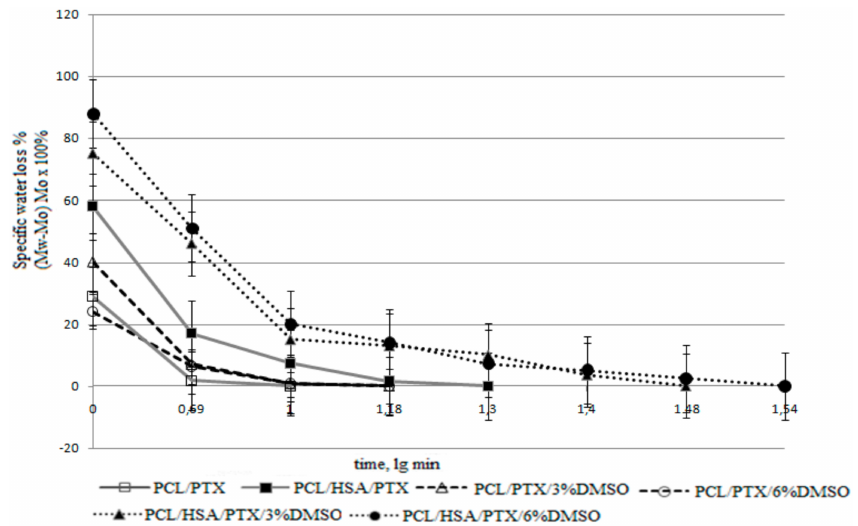
Figure 3. Drying rate of 3D matrices. The data presented as means, error of the mean does not exceed